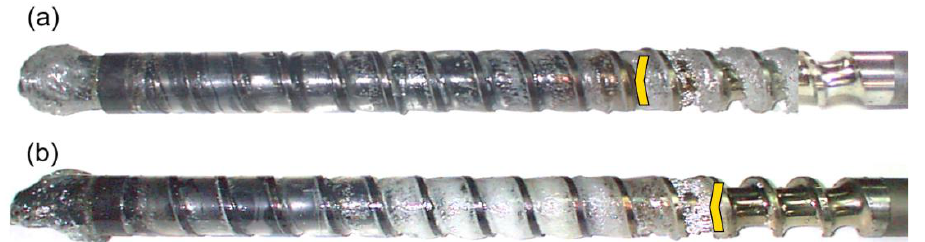
Figure 7. An effect of the screw speed on the polymer flow in the injection molding process at the plastication stroke h plast = 1 D, and the back pressure P back = 2 MPa: ( a ) N = 100 rpm, ( b ) N = 300 rpm.